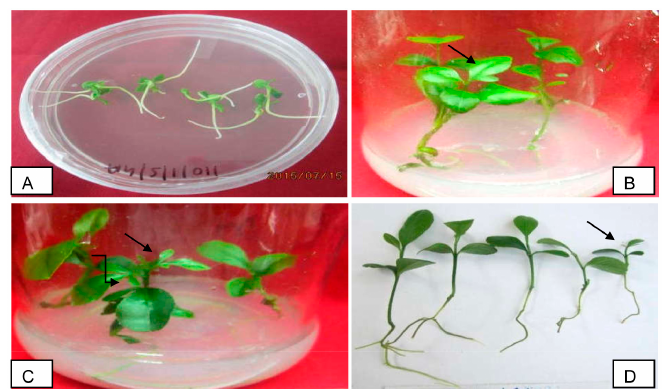
Figure 1. In vitro zygotic embryo germination in RL × SC; ( A ) In vitro germinated embryo with well developed root on MS + ME (0.75 g/L) + GA 3 (1.0 mg) + Sucrose (50 g/L), ( B ) plantlets with entire and bifoliate leaf, ( C ) plantlets with entire and trifoliate leaves, ( D ) seedlings after 40 to 50 days in the growth medium with entire and trifoliate leaves and arrows indicated bifoliate and trifoliate plantlets. The lowest embryo germination was observed at 65 DAP, indicating immaturity of